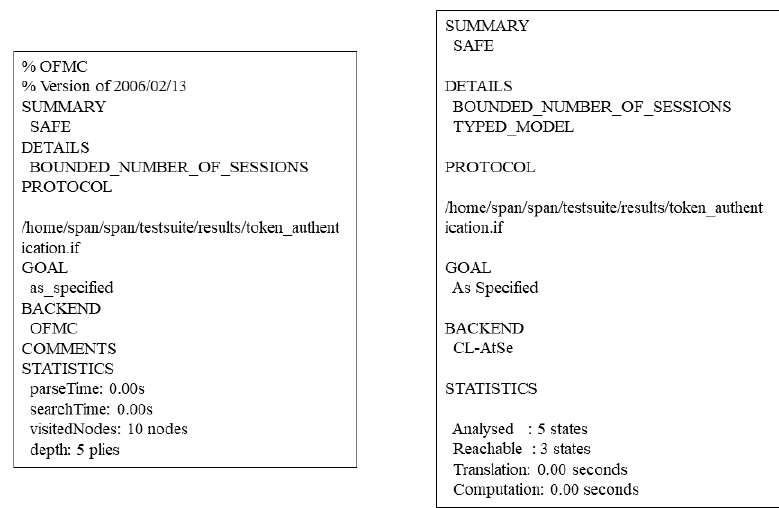
Figure 13. Results of AVISPA’s analysis of the “Token Authentication”